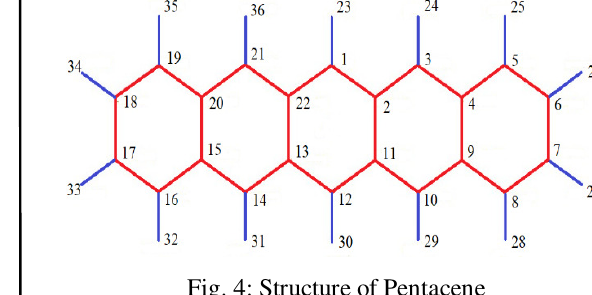
Fig. 4: Structure of Pentacene